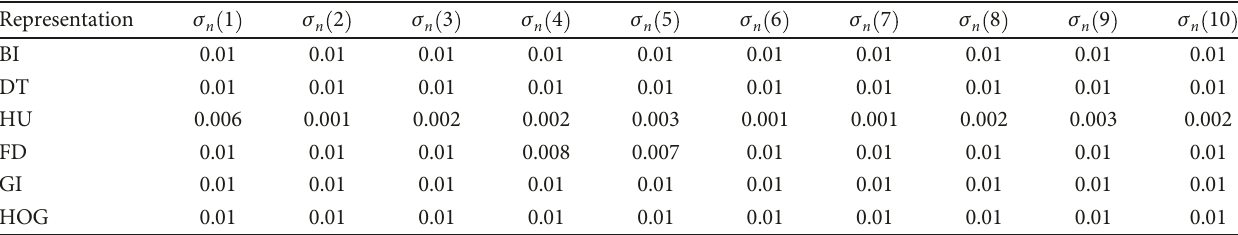
i indicates the variance in the i -th independent GPR model to predict the label vector. n